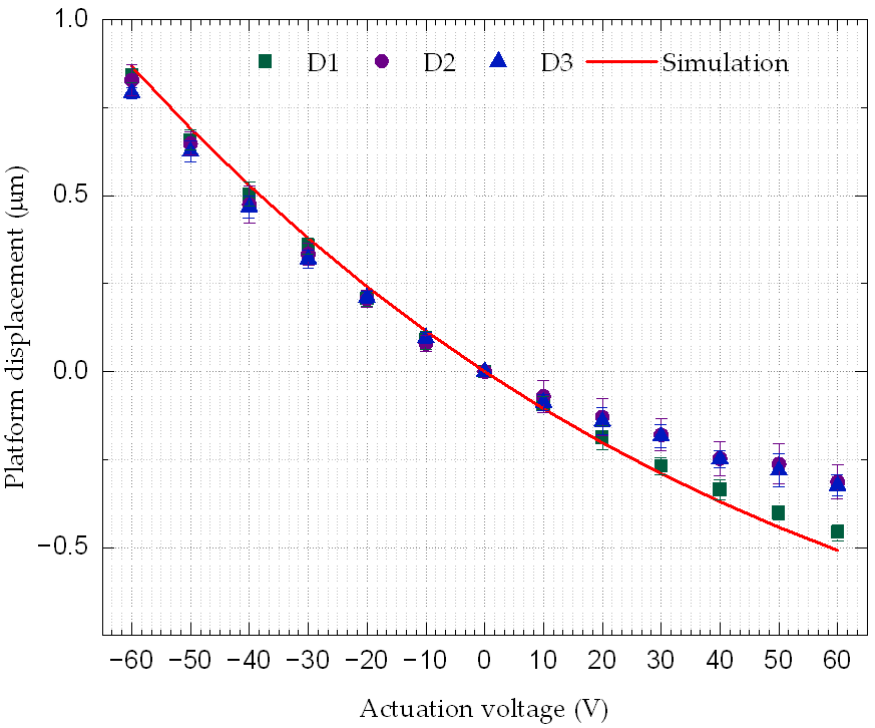
Figure 8. Averaged displacement for five measurement runs of three devices (D1, D2, and D3) versus the actuation voltage (the line represents the predicted behavior from the FEA simulation).